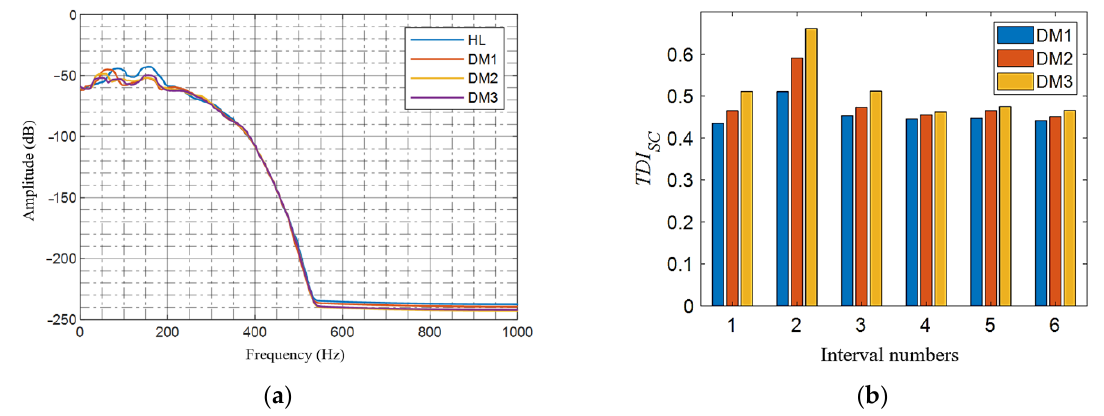
Figure 17. Verification of single additional mass damage in different degrees: ( a ) power spectrum curve of the tunnel acceleration under different degrees of additional mass damage in the second interval and ( b ) TDI SC at different degrees of additional mass damage in the second interval.